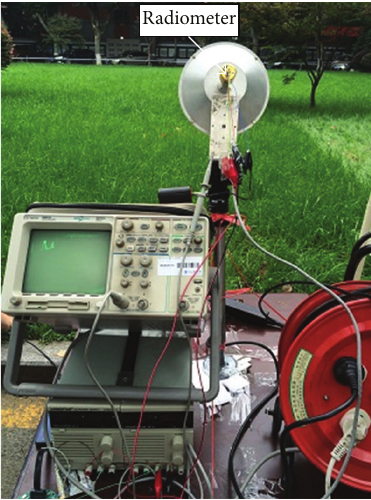
Figure 5: Measured scene of the grass.